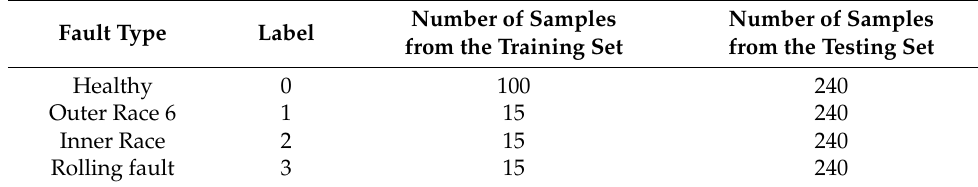
Table 1. Fault description of CWRU data.